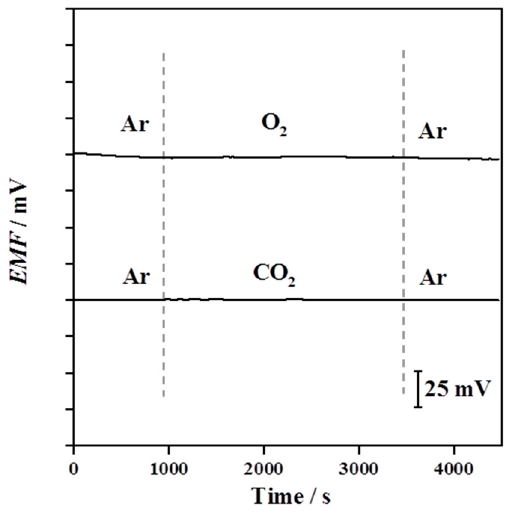
Figure 7. Influence of O 2 (top) and CO 2 (bottom) on the potential stability of Au / MWCNTs / (MMA-BA)-Pb 2 + -ISEs, which were immersed in a 1.5 × 10 − 3 mol · L − 1 Pb(NO 3 ) 2 solution. For clarity, the potential responses of theses electrodes have been shifted vertically.